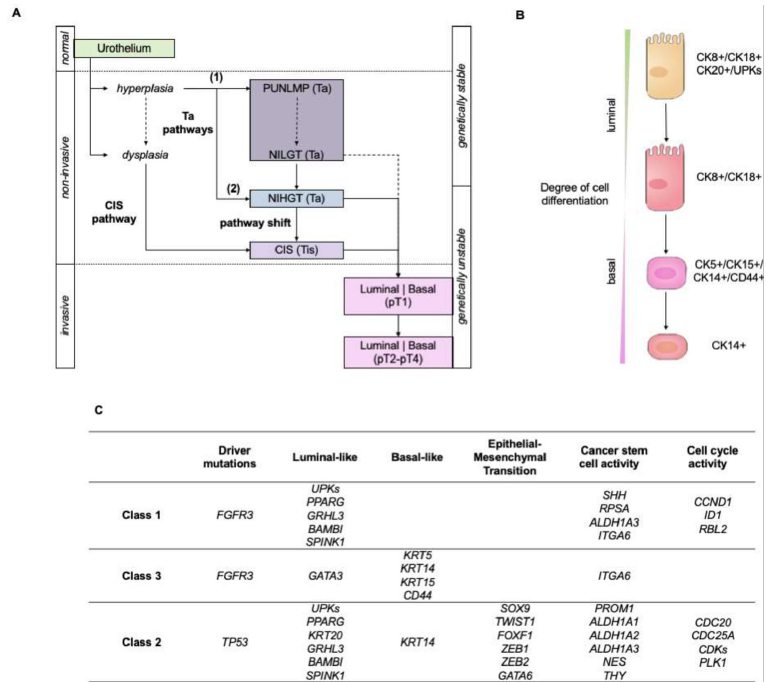
Figure 2. ( A ) Schematic representation of the potential pathways of bladder cancer tumor progression of bladder cancer pondering the and the ESMO (European Society for Medical Oncology) 2020 WHO (World Health Organization) 2016 staging classifications. PUNLMP: papillary urothelial neoplasm of low malignant potential. NILGT: non-invasive, low-grade tumor. NIHGT: non-invasive, high-grade tumor. CIS: carcinoma in situ. ( B ) Schematic representation of common changes in the expression of membrane-bound cytokeratins and uroplakins during the dedifferentiation of the urothelium in the early stages. It is a process where the epithelial cells lose their luminal differentiation to acquire a basal-like phenotype. ( C ) Summary of the representative molecular features for the Ta and the CIS pathways, including the class shift between them